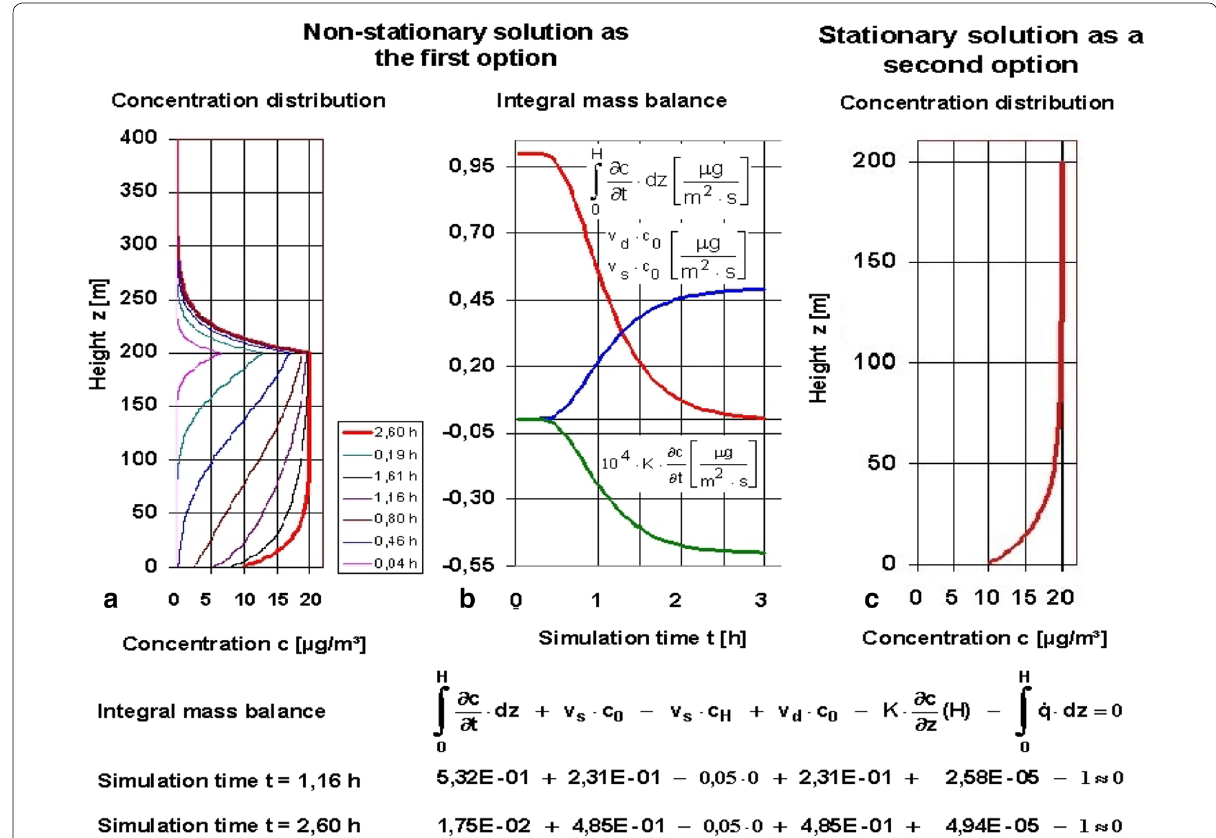
Fig. 6 Correct stationary and unsteady solution for the spreading case “Sedimentation with